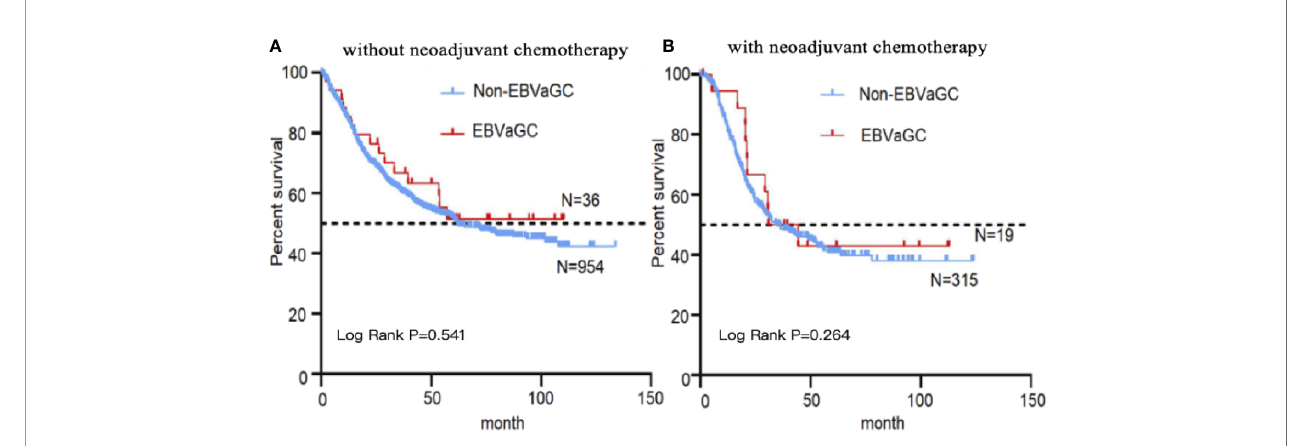
FIGURE 3 | Kaplan – Meier curves strati fi ed by EBV status. Kaplan – Meier survival analysis of EBVaGC and non-EBVaGC patients without (A) and with (B) neoadjuvant chemotherapy.